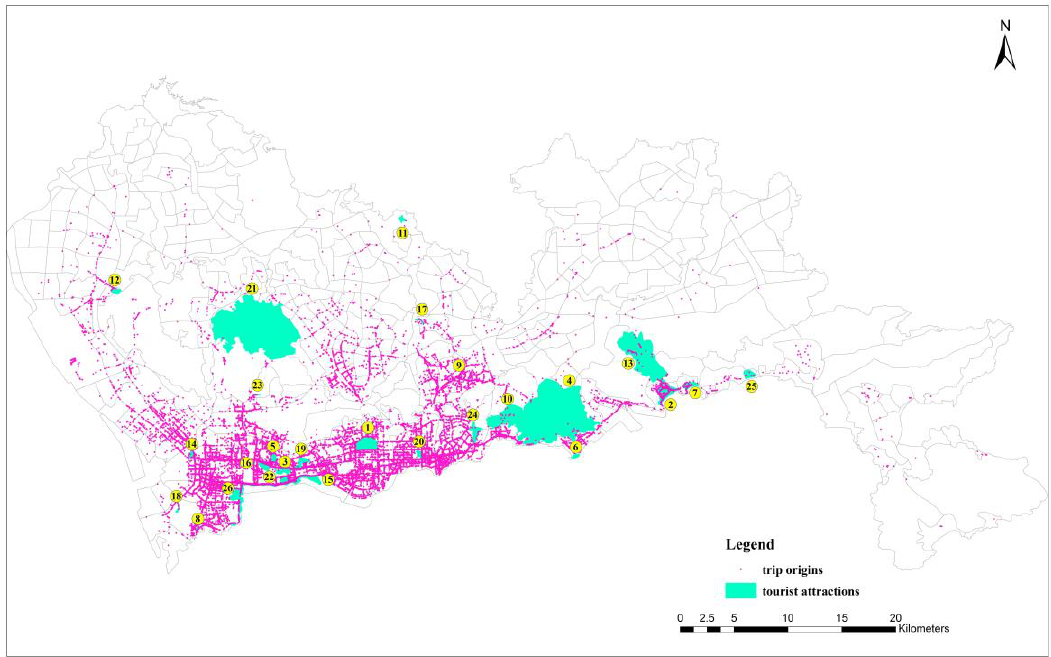
Figure 1. The spatial distribution of tourist attractions and trip origins in Shenzhen, China. The trajectory data were collected by 16,828 GNSS (Global Navigation Satellite System)- equipped taxis operating in Shenzhen, with an average sampling frequency of 30 s. In total, there are 69.16 million GNSS records. Each record includes the taxi’s identifica- tion, coordinates (i.e., latitude and longitude), instantaneous speed, time, and occupancy state (loading passengers or not). To explore the relationship between tourist trip ori- gins and geographic contextual factors, this study also used POI (Point of Interest) data and road network data. The POI data were crawled from the open API of Gaode Maps (https://lbs.amap.com/api/webservice/guide/api/search, accessed on 26 June 2021), with over 1.7 million records as of the end of September 2018 [30], and each POI record includes attributes such as name, address, type, longitude, and latitude. The POI data